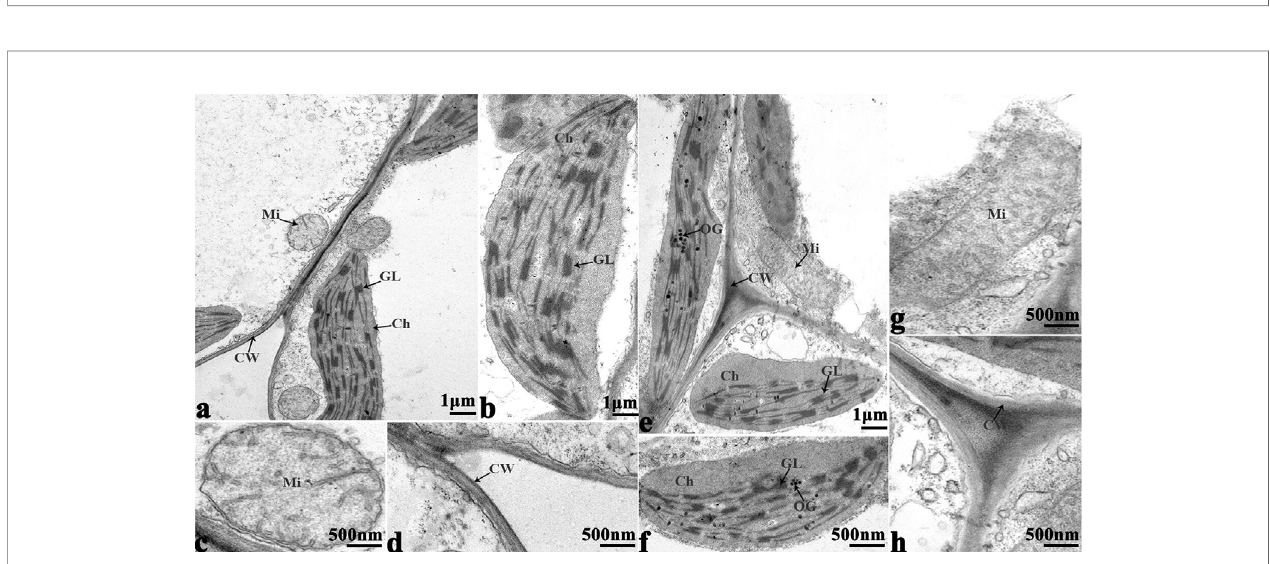
FIGURE 8 | B. napus cultivars 16NTS309 and Tianyou2238 under non-cold (A, C) and cold stress (B, D) conditions for 48 h. The deepest leaf vein samples with blue formazan precipitate areas in 16NTS309 (A, B) and Tianyou2238 (C, D) were sectioned for morphoanatomical analysis. ep, epidermis; xy, xylem; vb, vascular bundle. Scale bars = 100